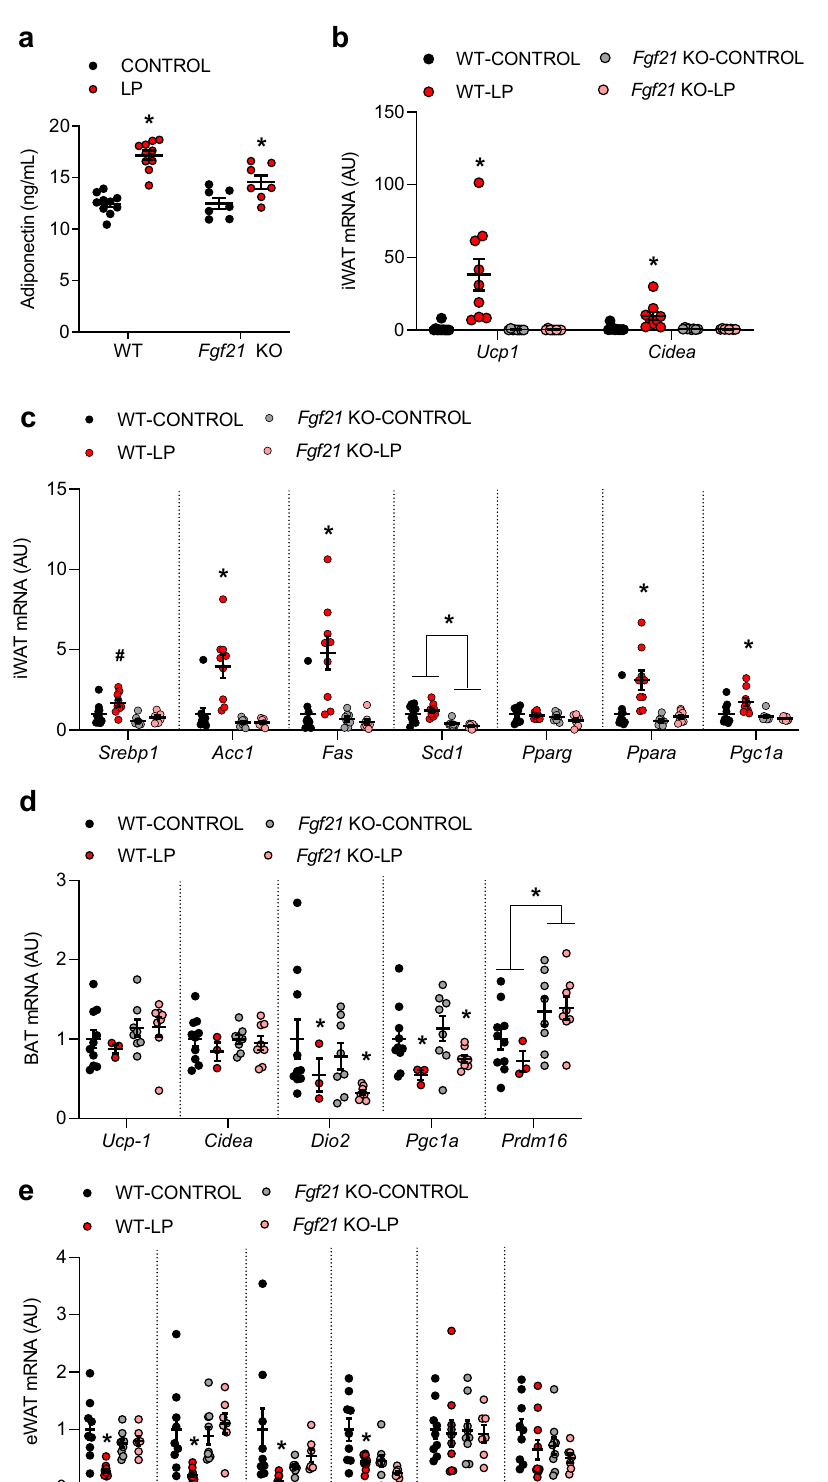
longevity effects of PR, male control and Fgf21 -KO mice were placed on a low protein diet at 3 months of age and were then allowed to age naturally. Collectively, the data demonstrate that FGF21 is not only required for the longevity effects of PR, but the absence of FGF21 converts the bene fi cial effect of PR to a detrimental effect. This work provides clear evidence that FGF21 plays a physiological role in longevity and identi fi es a